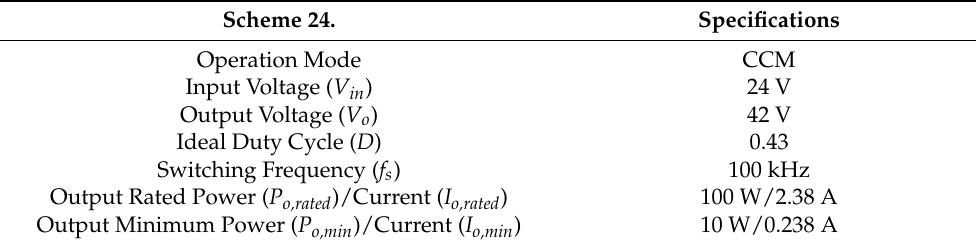
Table 2. System specifications. CCM, continuous conduction mode.